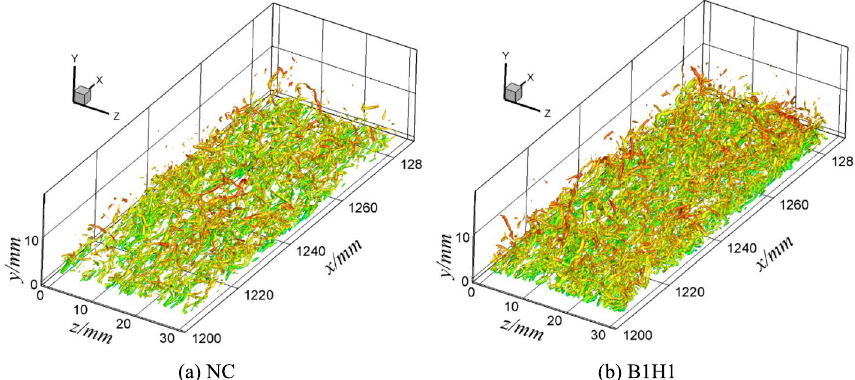
Fig. 15 Iso-surface of Q 0.2 to visualize vortical structures (colored by streamwise =